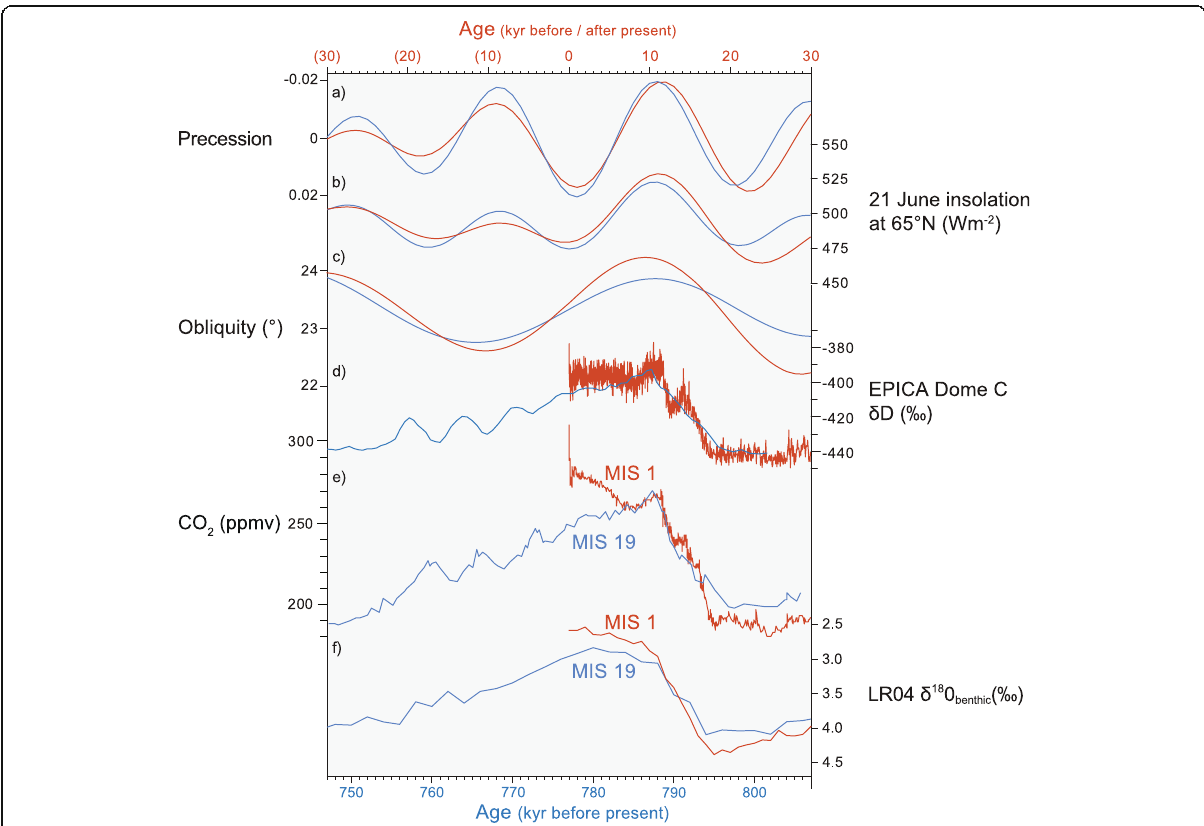
Fig. 13 Orbital and climatic characteristics of MIS 19 (blue) and the present interglacial MIS 1 (red) compared. ( a – c ) Orbital configurations and ( b ) insolation for MIS 19 and past and future MIS 1 (Laskar et al. 2004). ( d ) δ D composition of ice in the EPICA Dome C ice core as a proxy for Antarctic surface temperature (Jouzel et al. 2007). ( e ) Antarctic ice-core CO 2 values from the 0 – 800 kyr BP composite record of Bereiter et al. (2015, supplementary data) and show MIS 1 and MIS 19 in close alignment through the Early Holocene. ( f ) LR04 benthic stack of Lisiecki and Raymo (2005) showing lighter values for MIS 1, beginning ~ 11,000 years before present. Adapted from fig. 3 of Tzedakis et al.